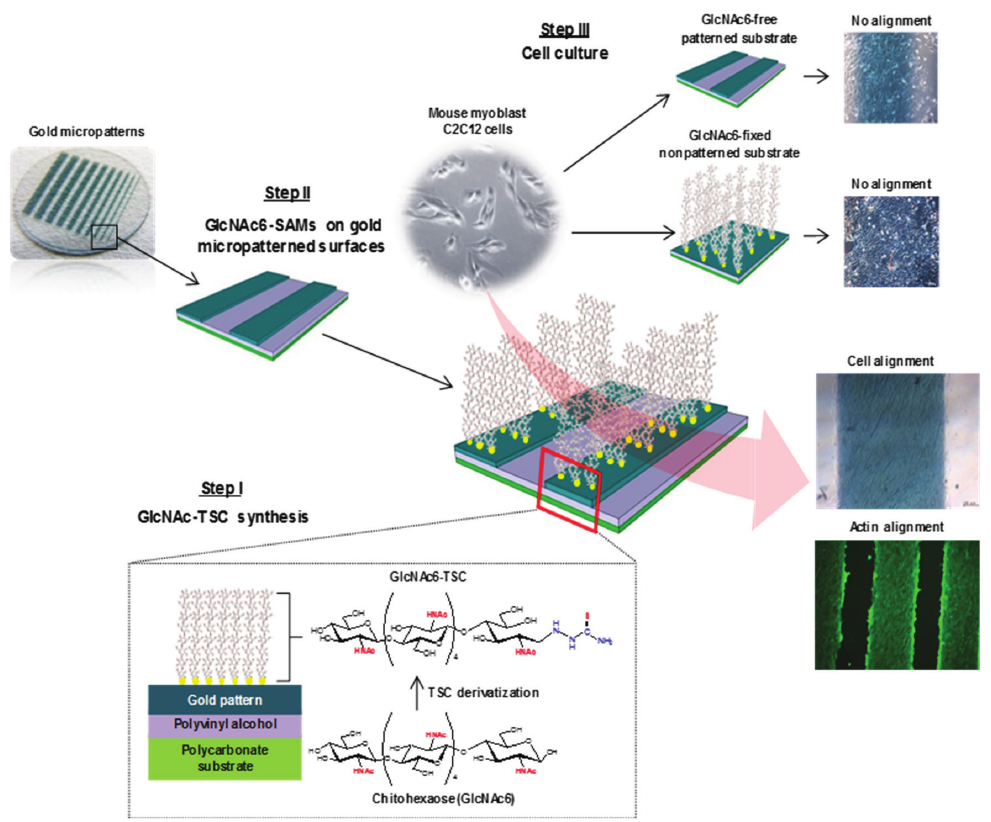
Figure 1. Schematic illustration of the preparation of GlcNAc6-SAMs with micropatterns and myoblast cell alignment through a specific interaction with glyco-receptors on cell surfaces.